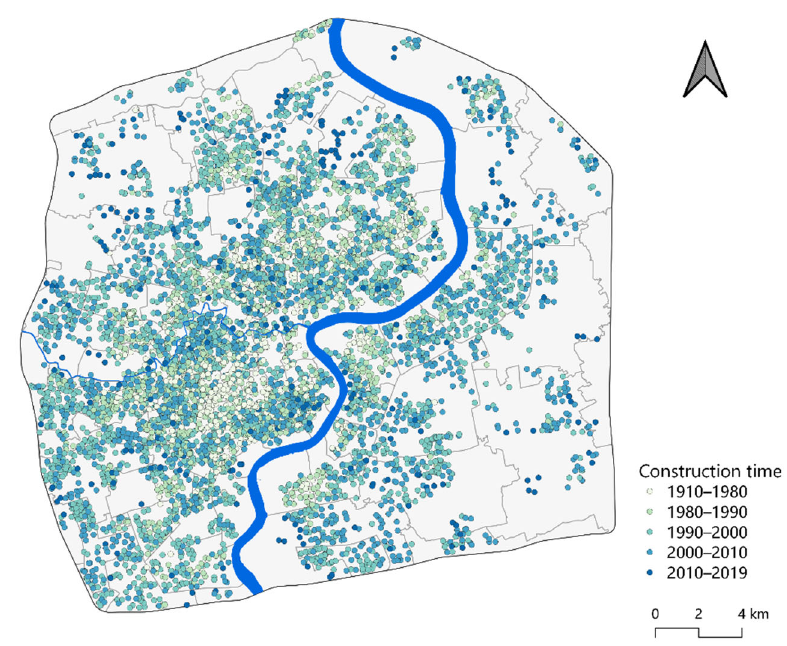
Figure 2. Distribution of community locations by years.